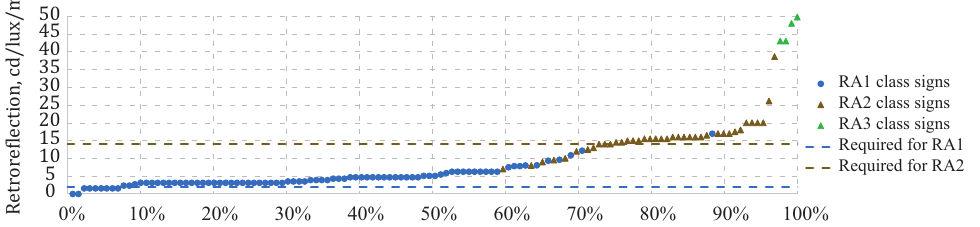
Figure 9. Traffic signs retroreflection coefficient for the blue